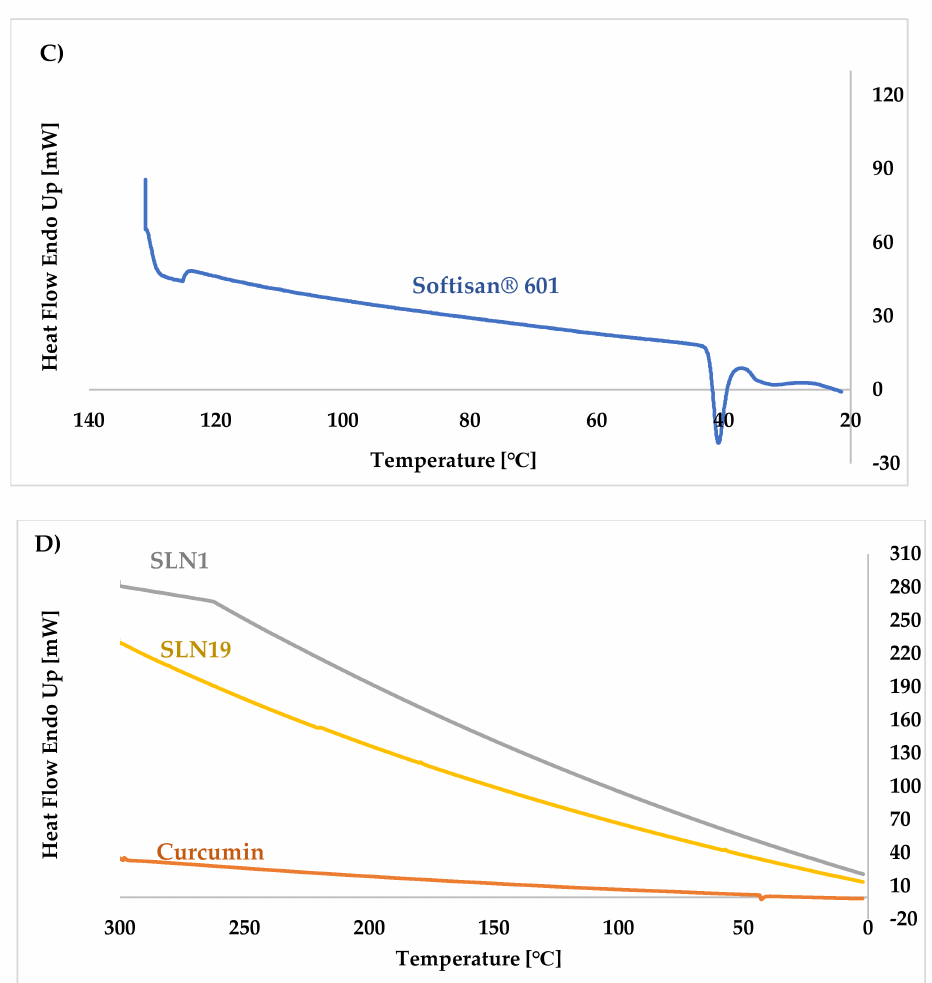
Figure 7. Comparison of DSC thermograms recorded ( A ) upon heating of Softisan ® 601 from 25 to 80 ◦ C, and ( B ) upon heating of the curcumin, SLN 1, and SLN 19 from 25 to 300 ◦ C; and comparison of DSC thermograms recorded ( C ) upon cooling of Softisan ® 601 from 140 to − 20 ◦ C and ( D ) upon cooling of curcumin, SLN 1, and SLN 19 from 300 ◦ C to − 20 ◦